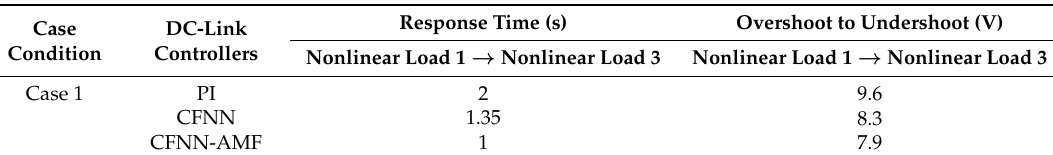
Table 3. Response time of DC-link voltage and regulation voltage error for different controllers at case 1.